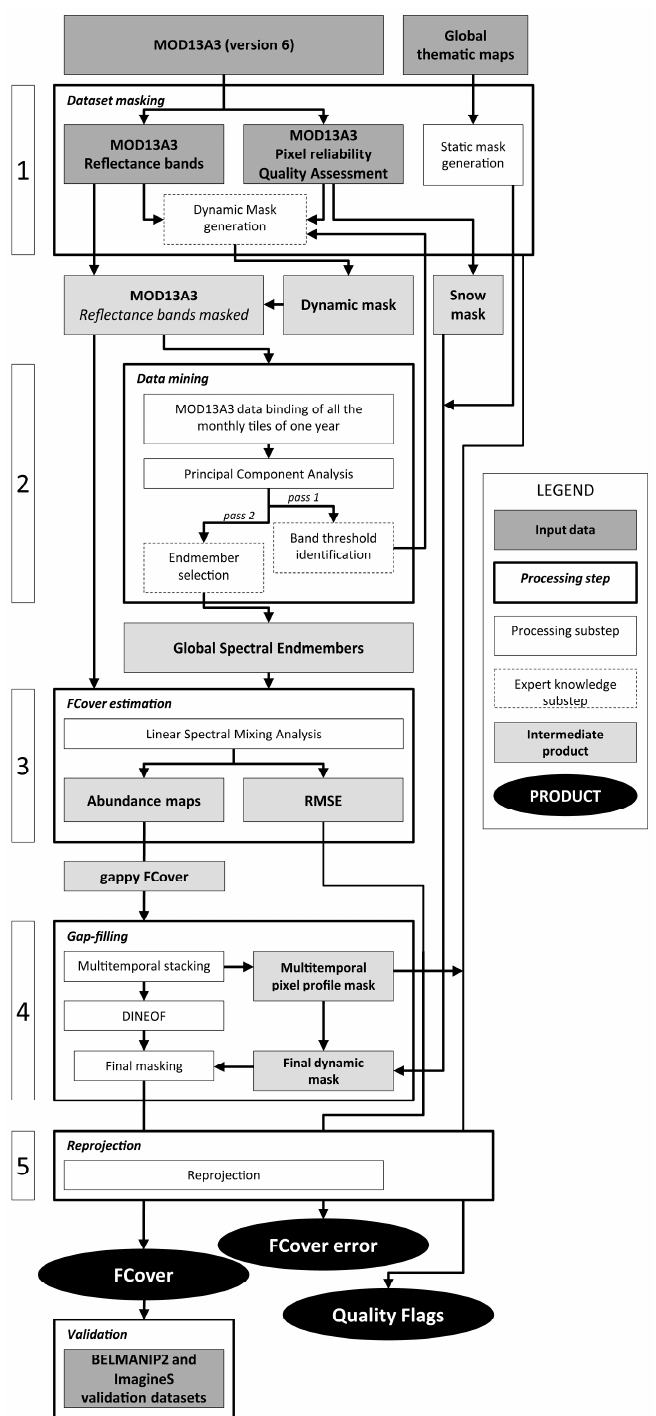
Figure 1. Processing chain developed to generate the global FCover product.